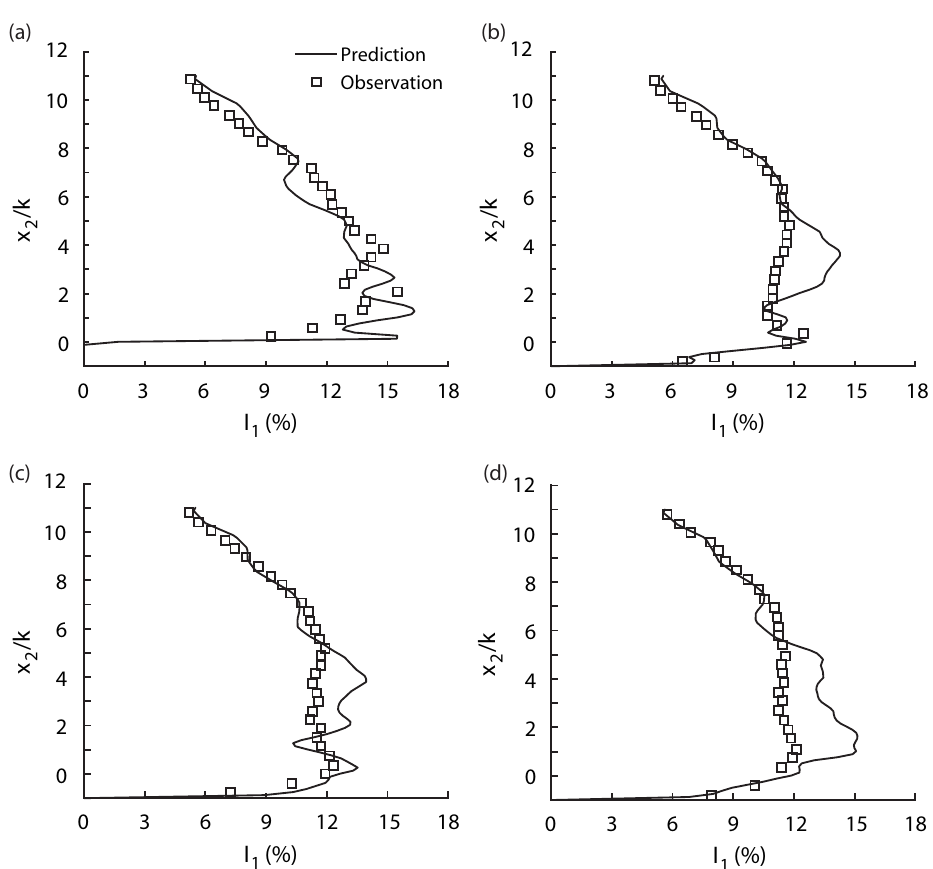
Figure 12. Vertical profiles of predicted turbulence intensity component I 1 in the streamwise direction for Run 4, compared with observed values [13]. Panels ( a – d ) correspond, in locations, to those in Figure